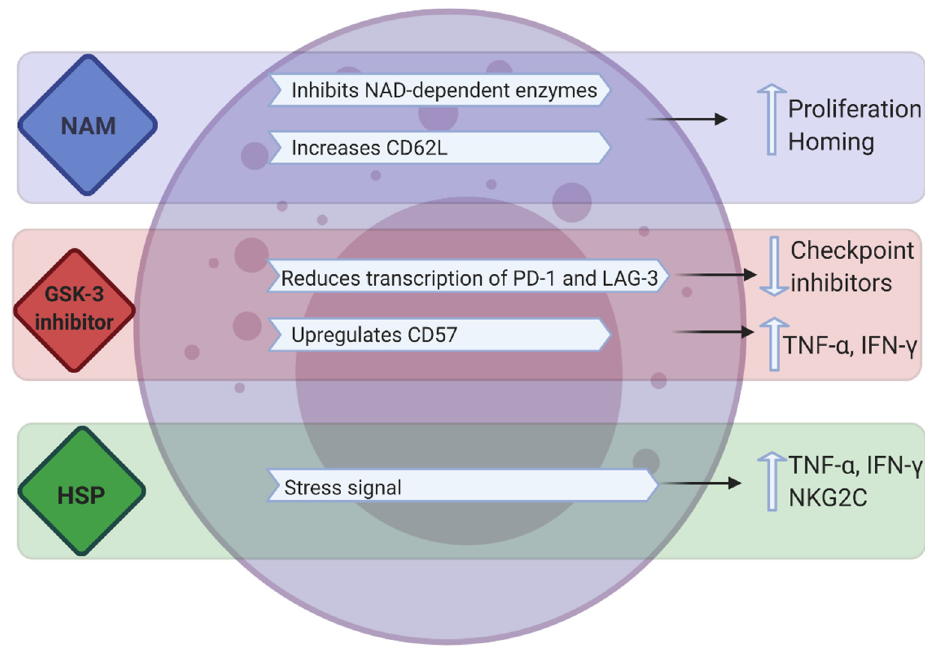
Figure 3. Effects of NAM, GSK-3 inhibition and HSPs on NK cell function. NAM induces the proliferation and homing of NK cells, while GSK-3 inhibition reduces checkpoint inhibitor transcription. HSPs are endogenous stress signals that induce an upregulation of NKG2C and both GSK-3 inhibition and HSPs induce a rise in TNF- α and IFN- γ levels. Abbreviations: CD, cluster of differentiation; HSP, heat shock protein; IFN- γ , interferon- γ ; LAG-3, lymphocyte-activation gene 3; NAD, nicotinamide adenine dinucleotide; NAM, nicotinamide; PD-1, programmed cell death protein 1; TNF- α , tumor necrosis factor α .